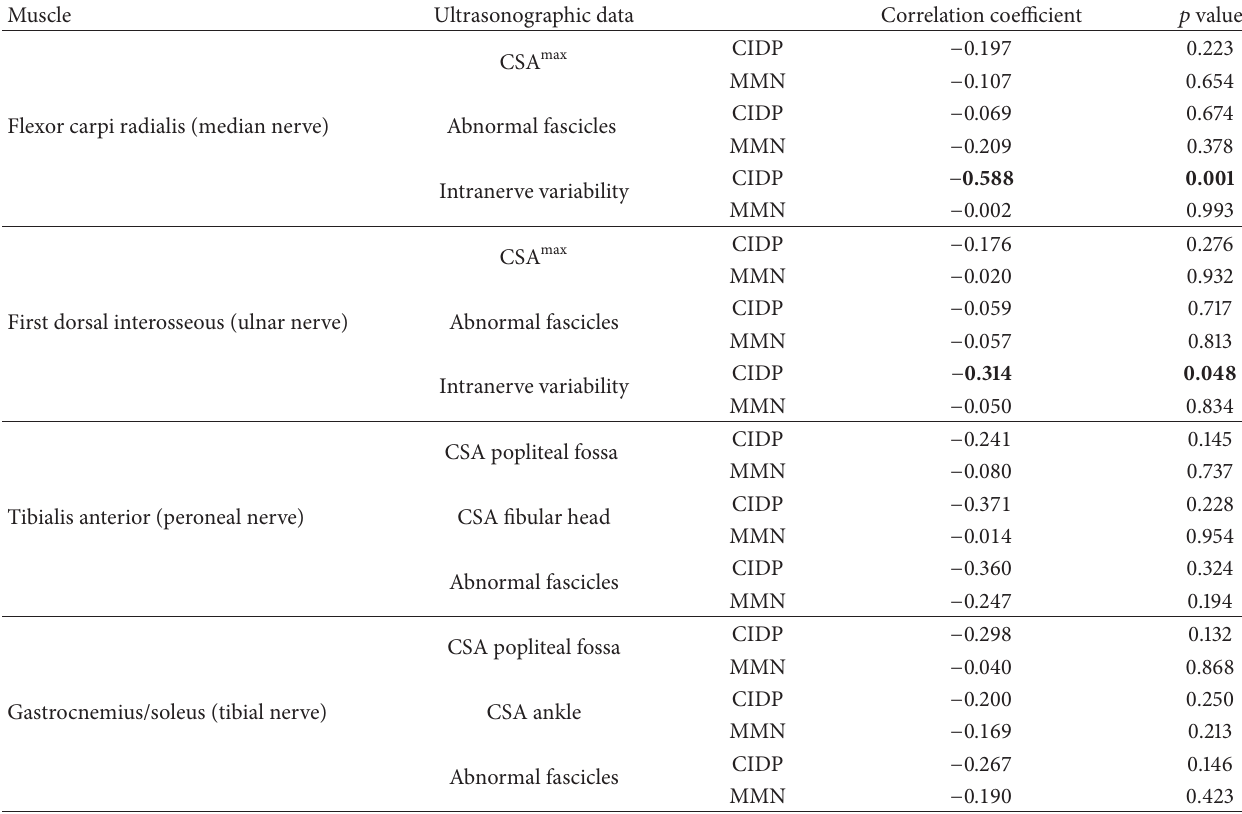
Table 5: Correlations between MRC score and corresponding ultrasonographic data in different muscles/nerves.